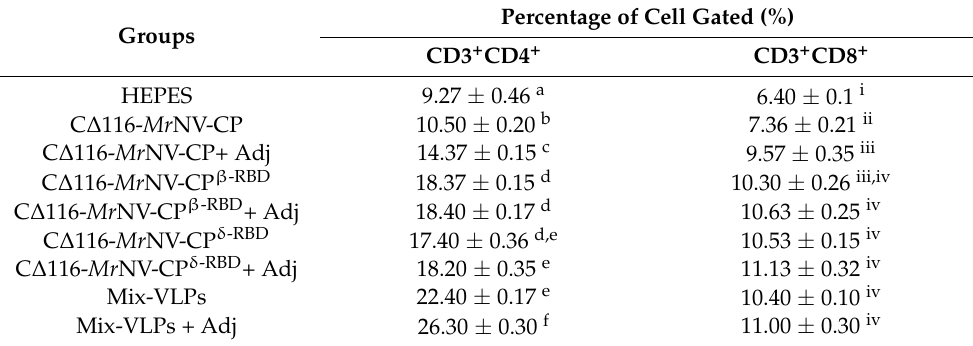
Table 1. Immunophenotyping of mouse